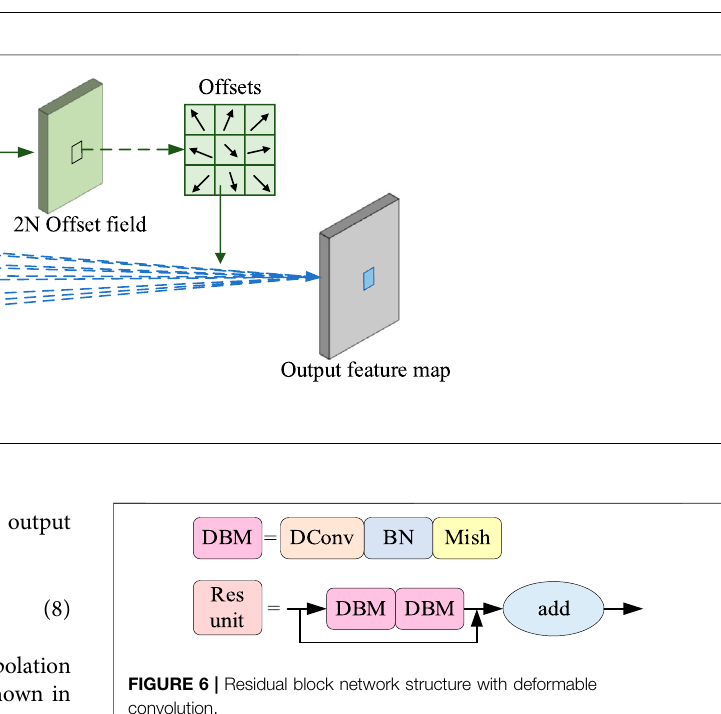
FIGURE 4 | Comparison of conventional convolution and deformable convolution sampling points. (A) is the sample point graph of the conventional convolution. (B – D) are sample point graphs of the deformable convolution.